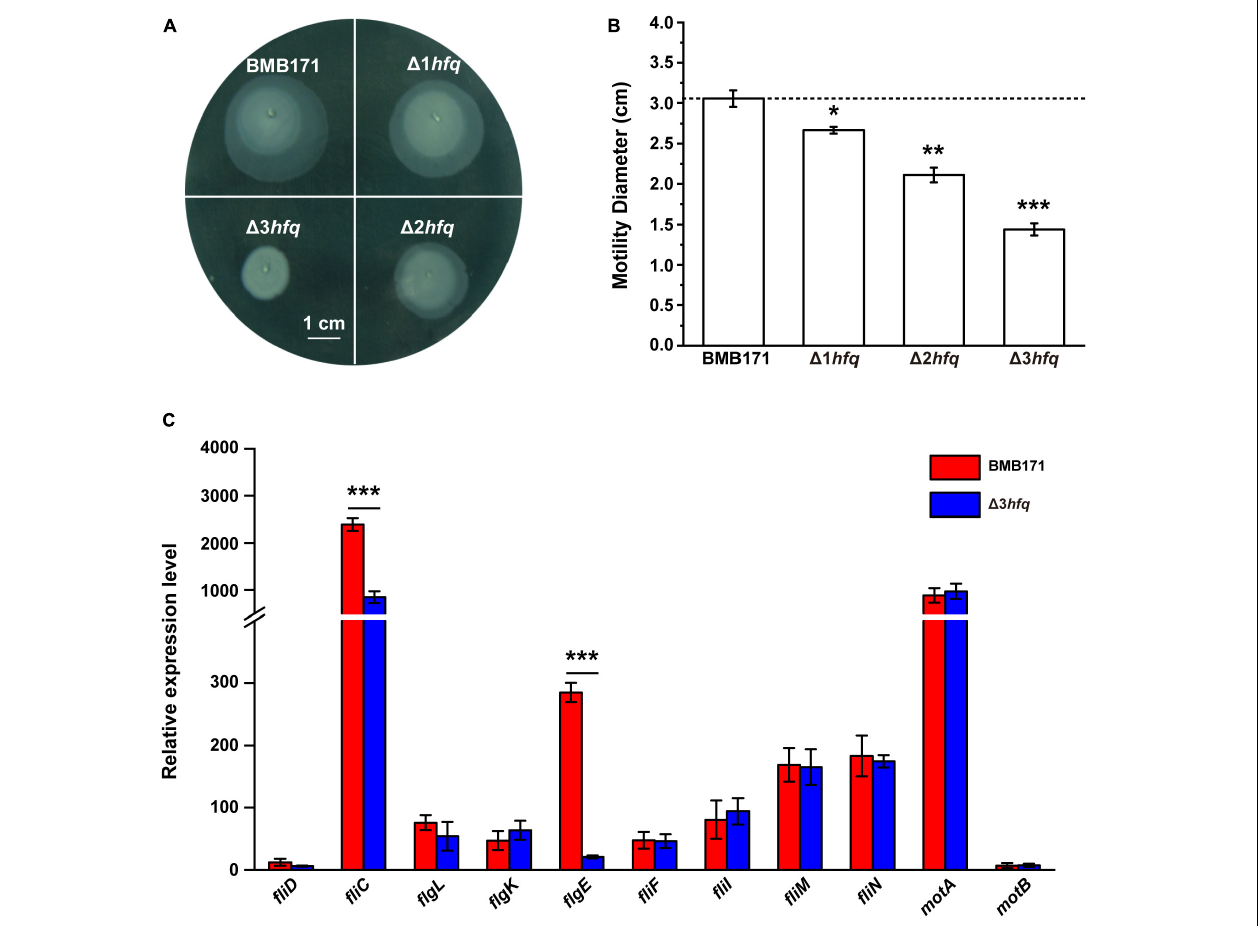
FIGURE 2 | Deletion of hfq results in reduced Bt motility. (A) Motility assay of BMB171, (cid:49) 1 hfq , (cid:49) 2 hfq , and (cid:49) 3 hfq on LB plates containing 0.5% agar. The scale bar is 1 cm. (B) Colony diameters of different strains. Motilities of BMB171, (cid:49) 1 hfq , (cid:49) 2 hfq , and (cid:49) 3 hfq were correspondent to colony diameter. (C) RT-qPCR measurements of 11 flagella formation-related genes in BMB171 and (cid:49) 3 hfq . The values are means ± SDs for triplicate assays. Significances of differences by Student’s t -test are indicated. *** p < 0.001; ** p < 0.01; * p <